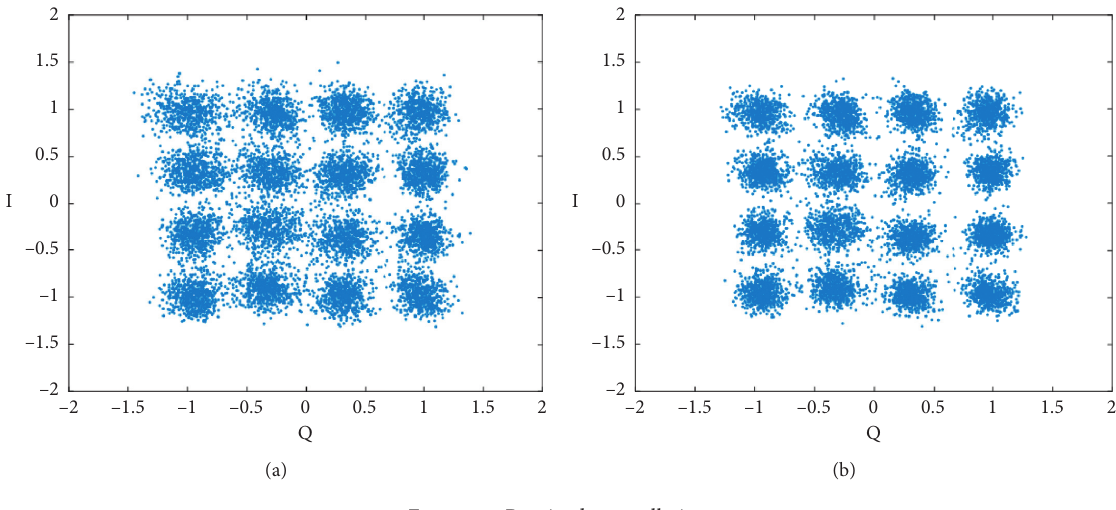
Figure 5: Received